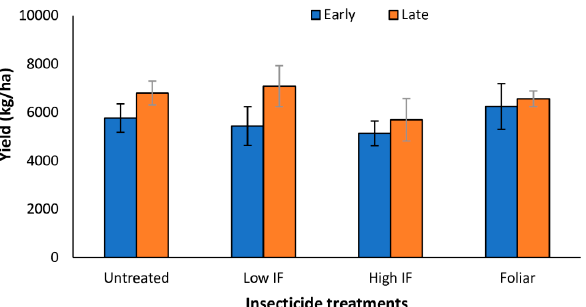
Figure 5. Mean (±SE) forage yield (kg/ha on a dry weight basis) in early and late planted forage sorghum treated with flupyradifurone in-furrow (IF) or foliar in 2021 in Tifton, GA. There were no differences in yield between both planting dates and among insecticide treatments ( p > 0.05; Turkey’s HSD test). Note: forage sorghum in the 2020 study were not harvested due to lodging and equipment breakdown.